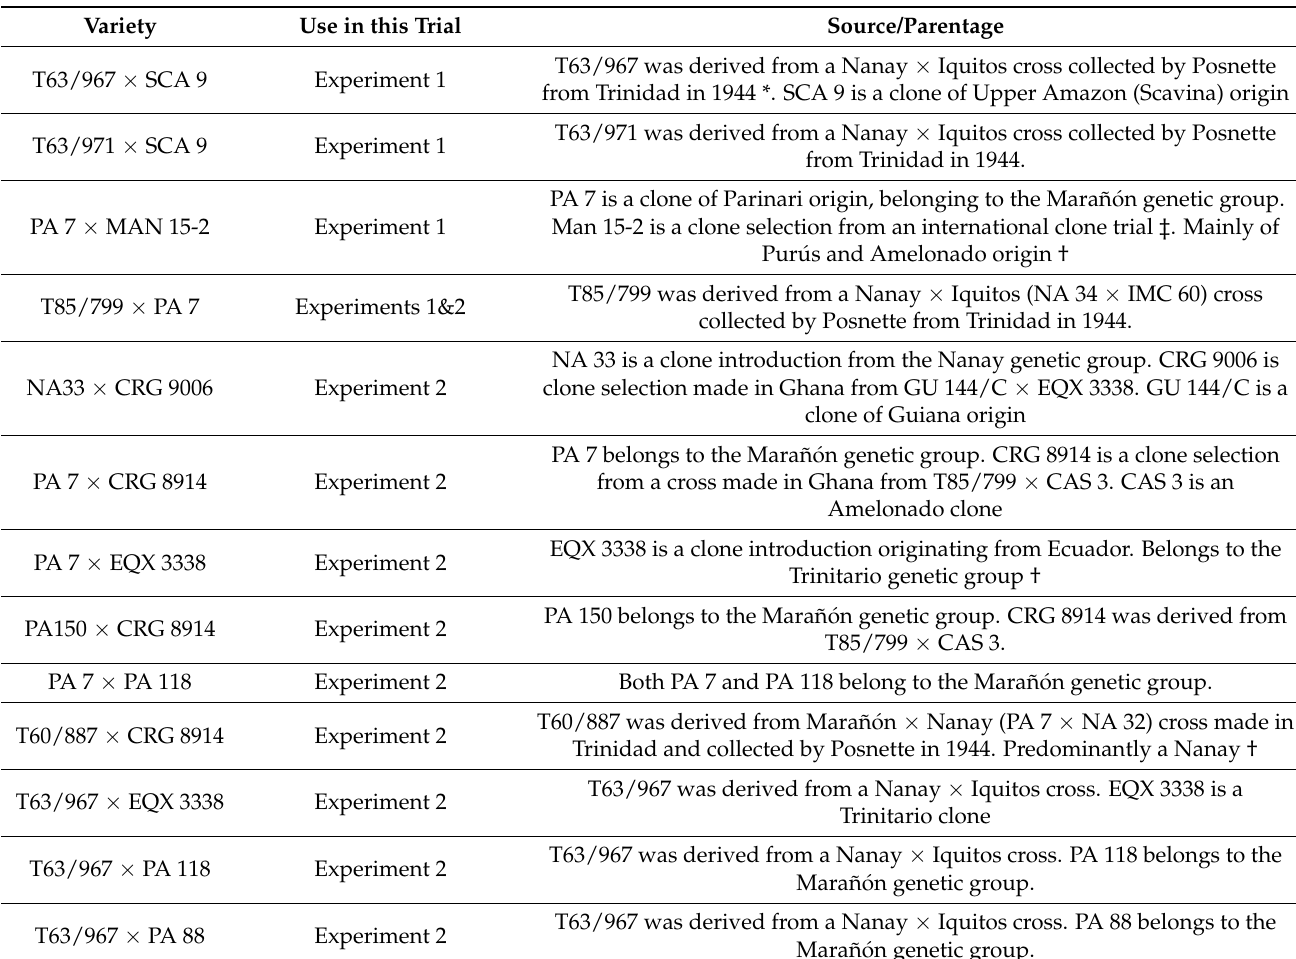
Table 1. Description of varieties used by pedigree or origin.